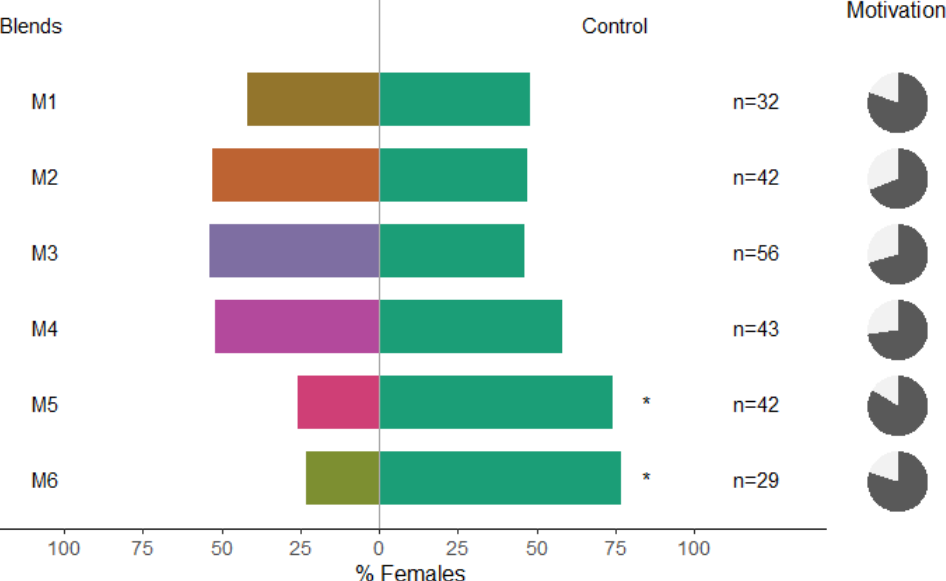
Figure 2. Results of Y-olfactometer-bioassays testing synthetic clove VOCs dissolved in methanol with adults of Cacopsylla pyricola . Pure methanol was used as control. The letter “n” corresponds to the numbers of insects used for the tests. Results are shown as the percentage of psyllids in each arm. Statistically significant differences are indicated with * ( p < 0.05). The percentage of psyllids that made a choice (dark gray) or not (light gray) is presented as pie charts on the right.